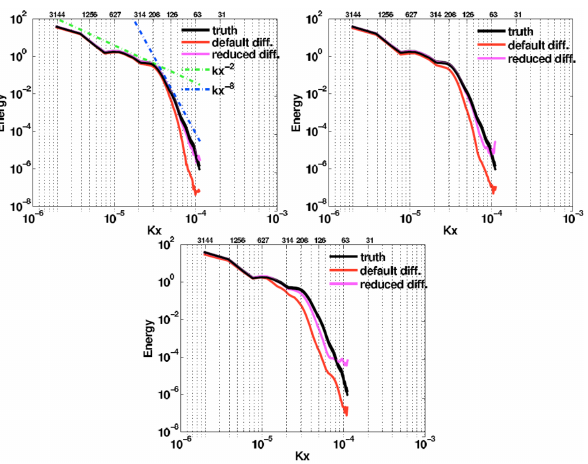
Figure 4. Kinetic energy mean power spectra calculated using the first layer velocity fields. Black curves represent the “true” initial condition power spectra; red curves represent the power spectra cal- culated after one forward–backward iteration without the nudging term and employing the reference diffusion coefficient; magenta curves represent the power spectra calculated after one forward– backward iteration without the nudging term and employing a re- duced diffusion coefficient. Top left: 5day assimilation window. Top right: 10day assimilation window. Bottom: 20day assimilation window. In the bottom abscissa, the tick labels stand for longitudi- nal wave number (radm − 1 ), while in the top abscissa, the tick labels stand for the corresponding wavelengths in km